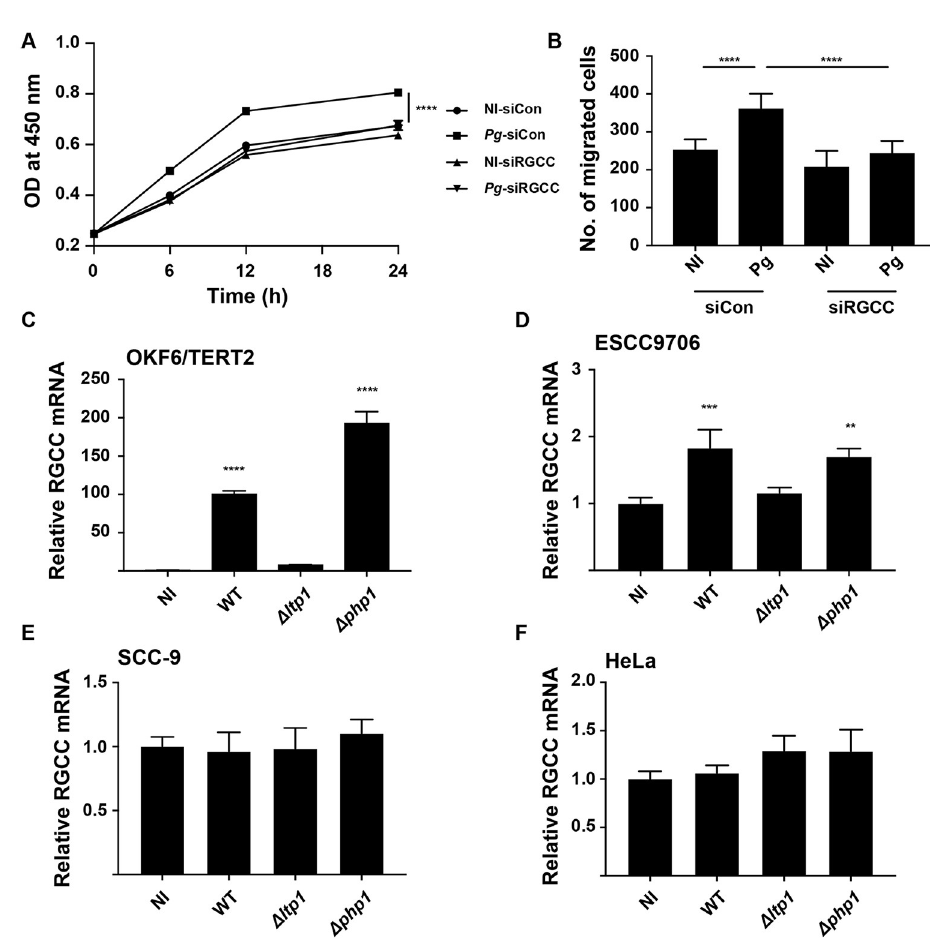
Fig 5. RGCC controls TIGK proliferation and migration in response to P . gingivalis and is regulated in different cell types. TIGK cells were transiently transfected with siRNA to RGCC (siRGCC) or scrambled siRNA (siCon) and challenged with P . gingivalis (Pg) or left uninfected (NI). A) Absorbance at 450 nm measured over the times indicated in a BrdU proliferation ELISA. B) Quantitative analysis of TIGK migration through matrigel-coated transwells. C-F) Cells as indicated were challenged with P . gingivalis WT, Δ ltp1 , or Δ php1 . Expression of RGCC mRNA was measured by qRT-PCR. Data are expressed relative to noninfected (NI) controls. �� p < 0.01, ��� p < 0.005, ���� p < 0.001.